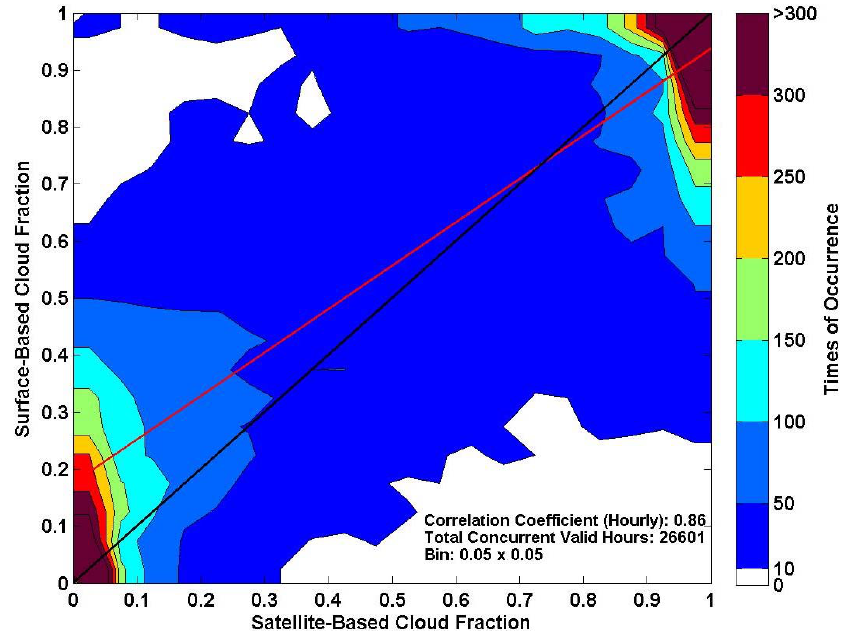
Fig. 2. Comparison between the surface-based and satellite-based cloud fractions. The red line denotes the linear fit to all the data points while the black diagonal line shows the perfect match as a